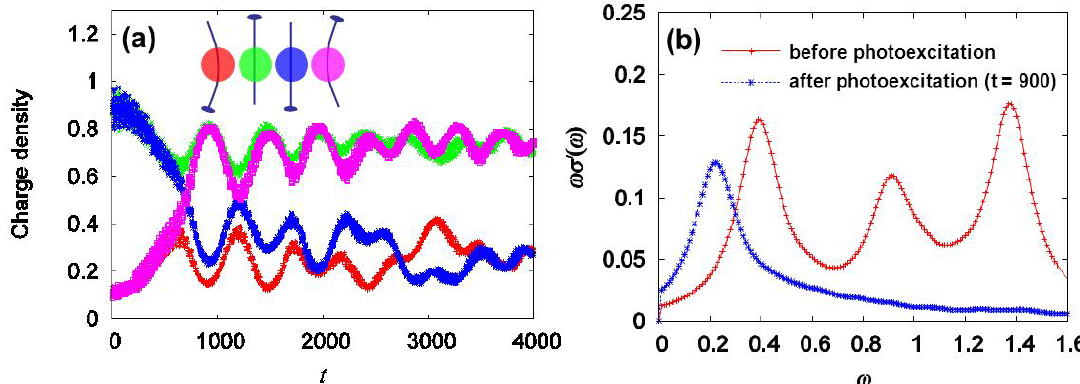
Figure 7. ( a ) Dependencies of charge densities on time in tetramer of EDO-TTF based on model calculations. Each colored line represents change in each EDO-TTF molecule as illustrated in inset; ( b ) Calculated spectra before and after photoexcitation [29]. Reproduced with permission from Onda et al . [29]. Copyright (2008) by the American Physical